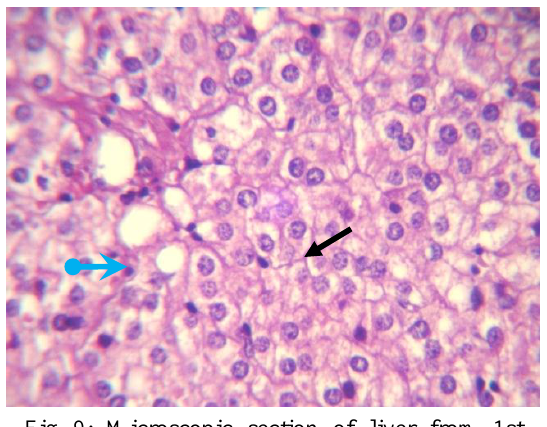
Fig 10: Microscopic section of kidney from 1st immunized group at 20 days post challenge show MNCs infiltration mainly lymphocyte between renal tubules (H&E X20).